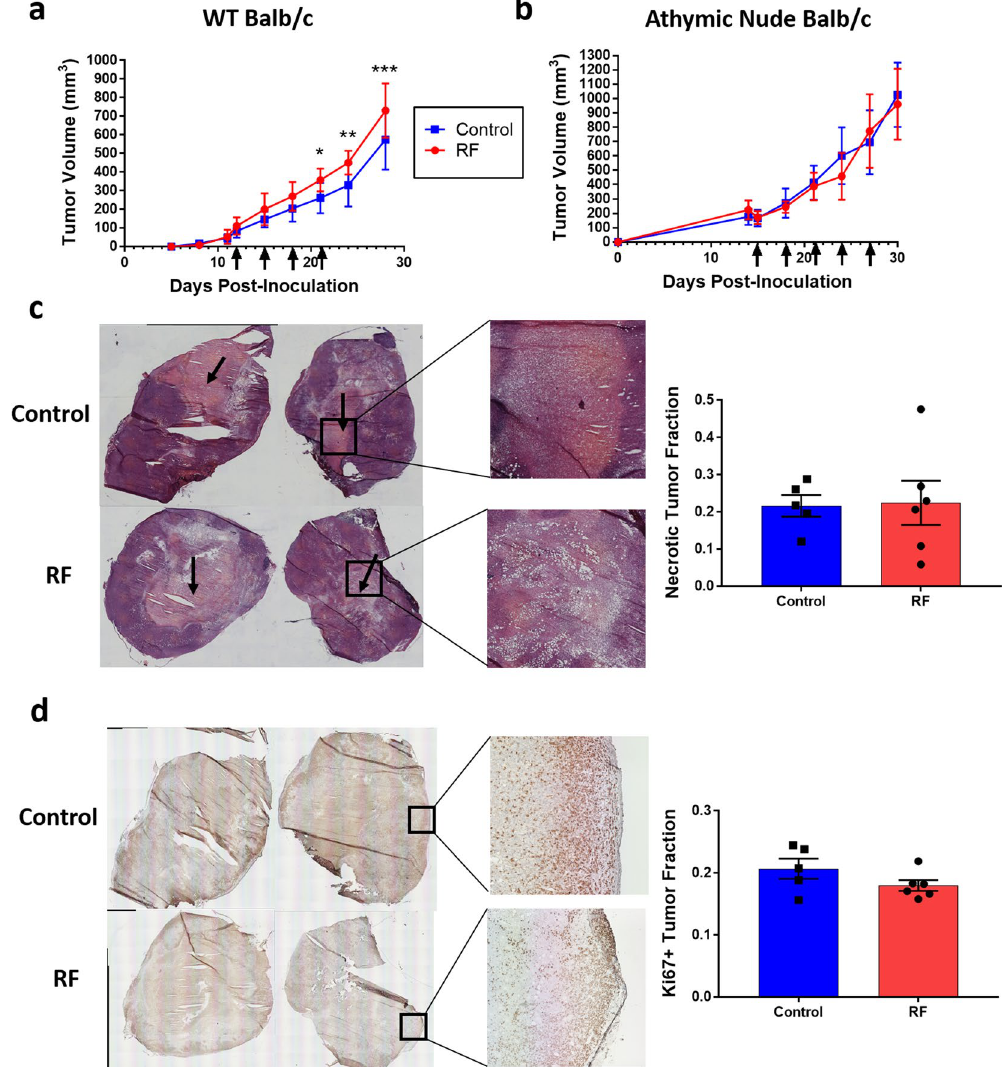
Figure 2. Consecutive-dose RFT induces T-cell dependent tumor growth effect with no effects on tumor necrosis or proliferation. 4T1 tumor volume following multiple consecutive RFT (41 °C, 30 mins; date of treatment indicated by black arrows) in either ( a ) wild-type Balb/c mice or ( b ) athymic nude Balb/c mice (n = 10/group). ( c ) Representative H&E histology images of control (top) and RF-treated (bottom) tumors at termination (black arrow denotes necrotic region), with zoom-in of necrotic region to the right. Quantification of necrotic fraction is provided to the far right comparing RF-treated and control mice (n = 5–6/group). ( d ) Representative IHC images showing Ki67 expression comparison between control (top) and RF-treated (bottom) tumors, with zoom-in of highly proliferative tumor periphery to the right. Quantification of Ki67 + tumor fraction is provided to the far right comparing RF-treated and control mice (n = 5–6/group). Error bars represent SEM. (See Supplemental Figure S3 for complete image set). ( * p < 0.05, ** p < 0.01, *** p <